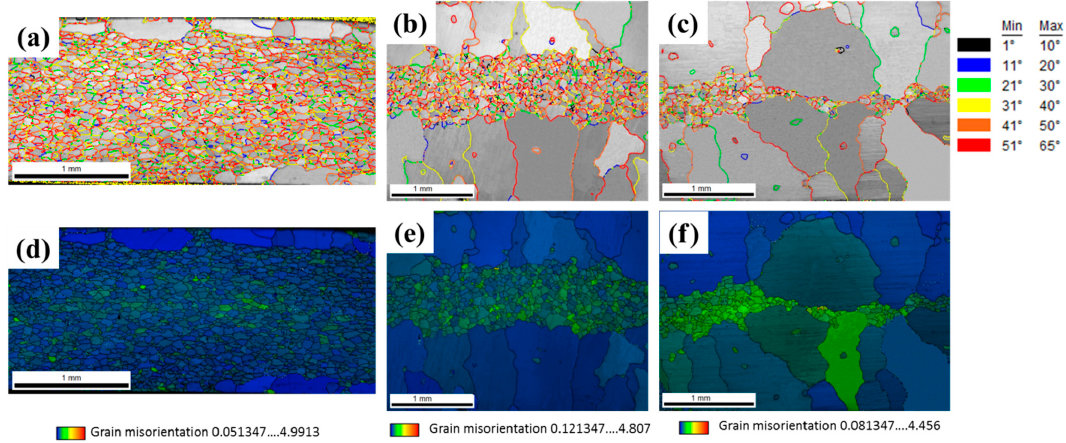
Figure 6. Maps of the angle of disorientation of samples annealed at 710 °C for ( a ) 12 h, ( b ) 36 h and ( c ) 48 h and GAM–EBSD maps of samples at ( d ) 12 h, ( e ) 36 h and ( f ) 48 h. Images were taken through the thickness of the strips.